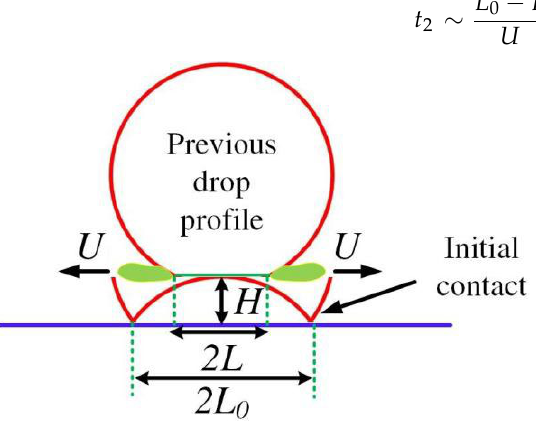
Figure 6. The second stage of compression.